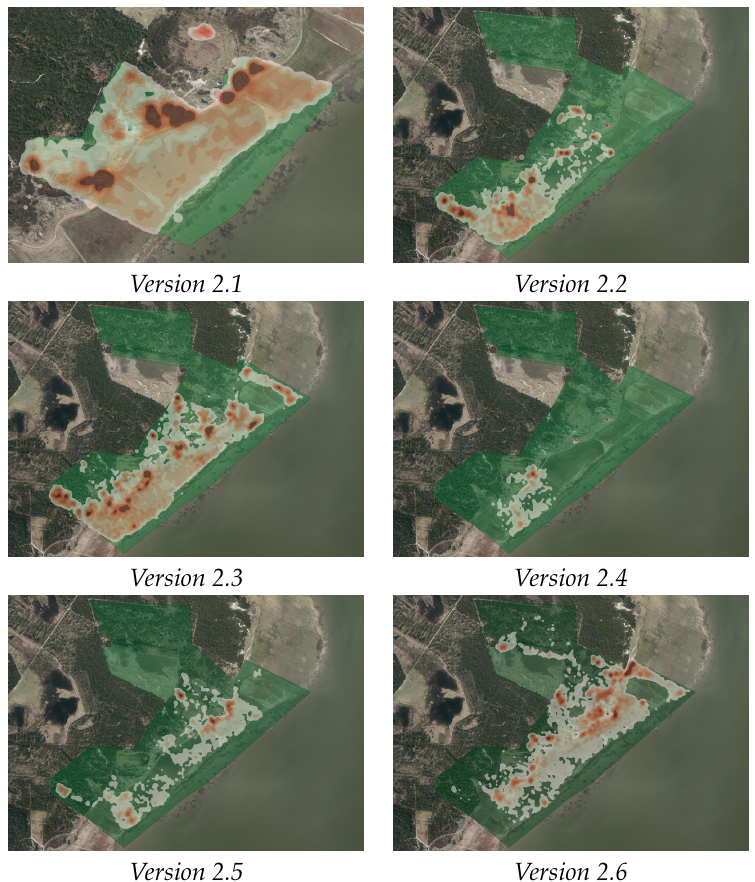
Figure A7. Heatmaps showing the cows’ distribution within the different versions of the virtual enclosure during period 2. The light green area represents the area of the virtual enclosure for each version.